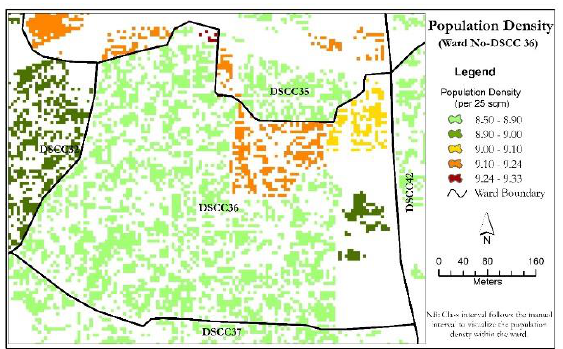
Figure 9. Raster-based land use map of sample ward Dhaka South 36 (DSCC36).